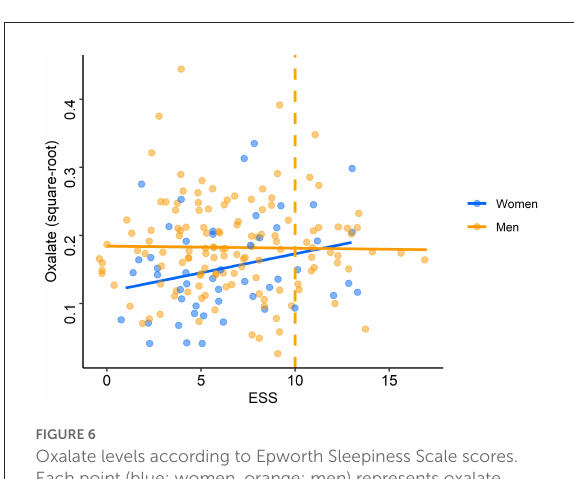
FIGURE6 Oxalate levels according to Epworth Sleepiness Scale scores. Each point (blue: women, orange: men) represents oxalate concentration (after square-root transformation) for each driver according to the score on the Epworth Sleepiness Scale (ESS). The orange dashed line represents the pathological threshold of the